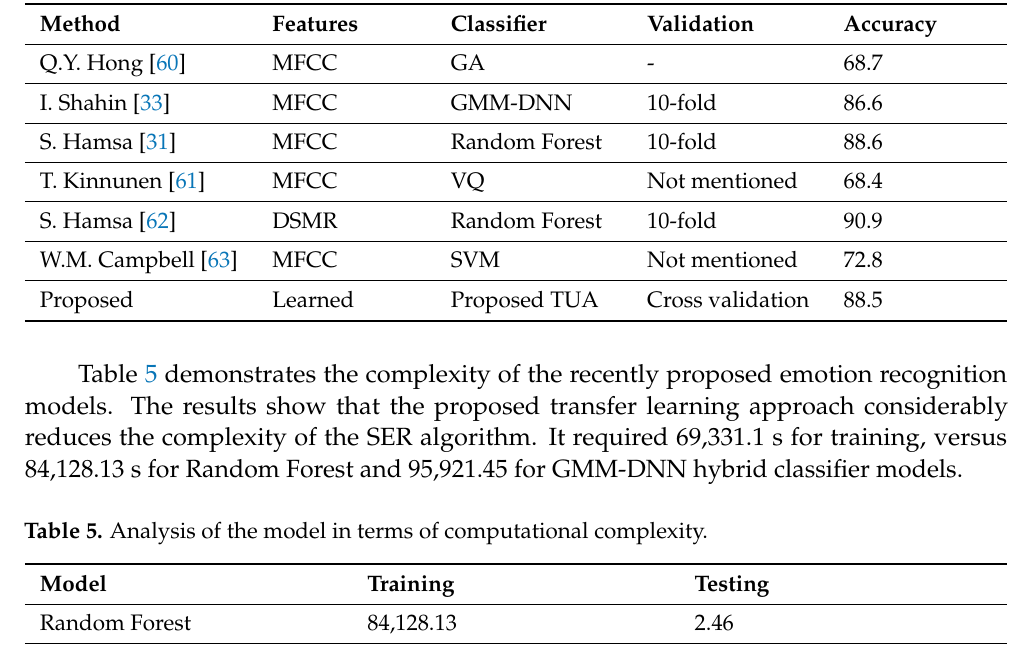
Table 4. Performance study of various methods utilizing the SUSAS dataset.